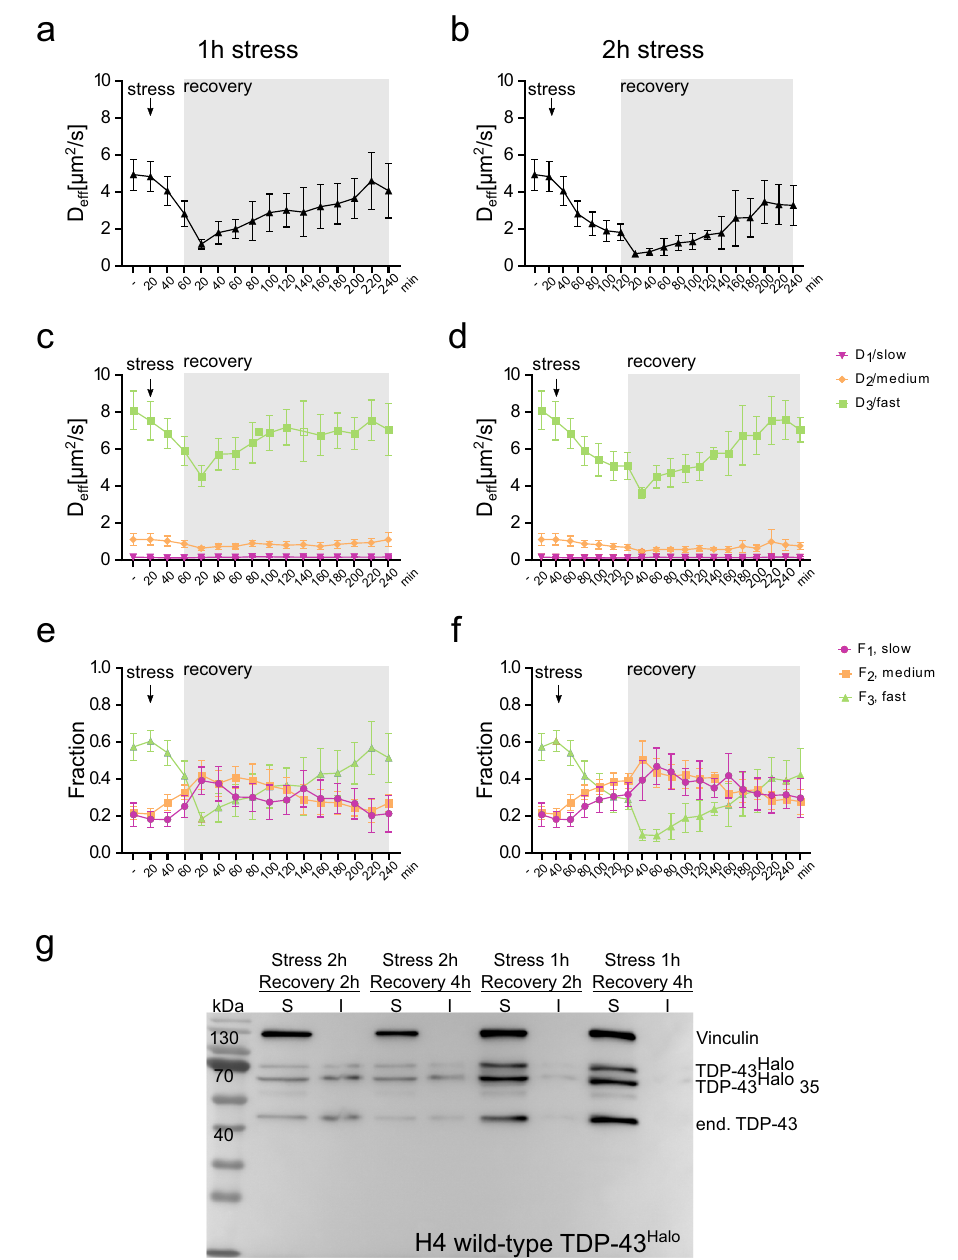
Fig.4|Stressandrecoveryexperiment.a , c , e Stressandrecoverytimecoursesof the effective diffusion coef fi cient D eff and the diffusion coef fi cients D 1 (slow), D 2 (medium) and D 3 (fast) and their respective amplitudes ( F 1 , F 2 , F 3 ) plotted for the wholecellfor1hstressdurationandupto4hofrecovery(green: D 3 / F 3 ,orange: D 2 / F 2 , red: D 1 / F 1 ). Stress and recovery start points are marked by arrows. Source data are provided as a Source Data fi le. b , d , f Stress and recovery time courses of the effective diffusion coef fi cient D eff and the diffusion coef fi cients D 1 (slow), D 2 (medium) and D 3 (fast) and their respective amplitudes ( F 1 , F 2 , F 3 ) plotted for the wholecellfor2hstressdurationandupto4hofrecovery(green: D 3 / F 3 ,orange: D 2 /